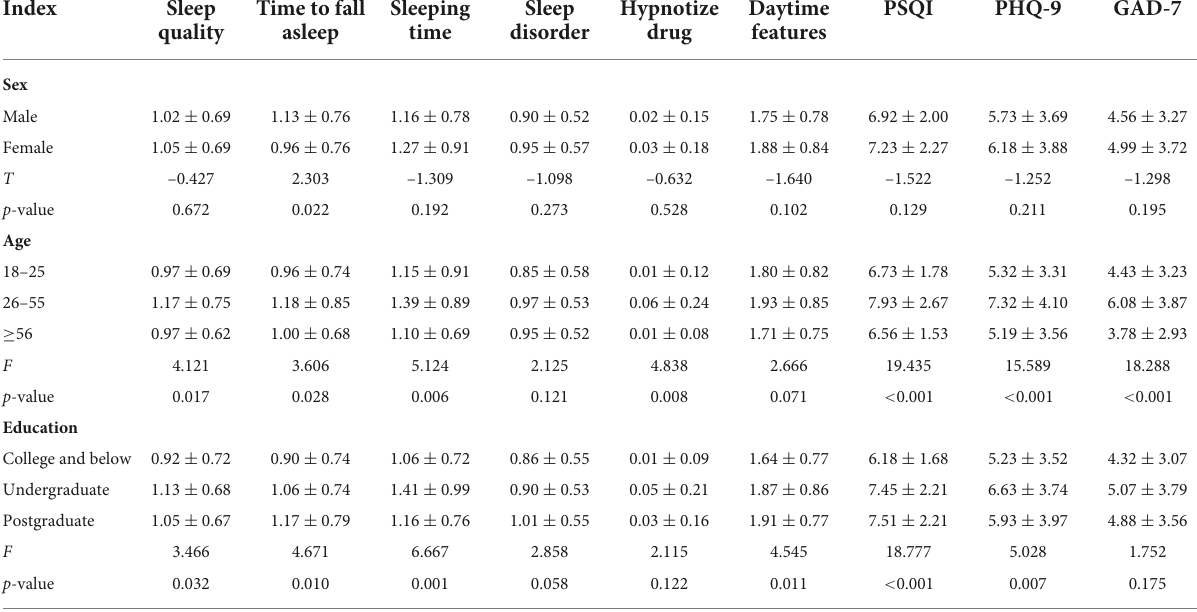
TABLE 2 Comparison of sleep quality, depression and anxiety.